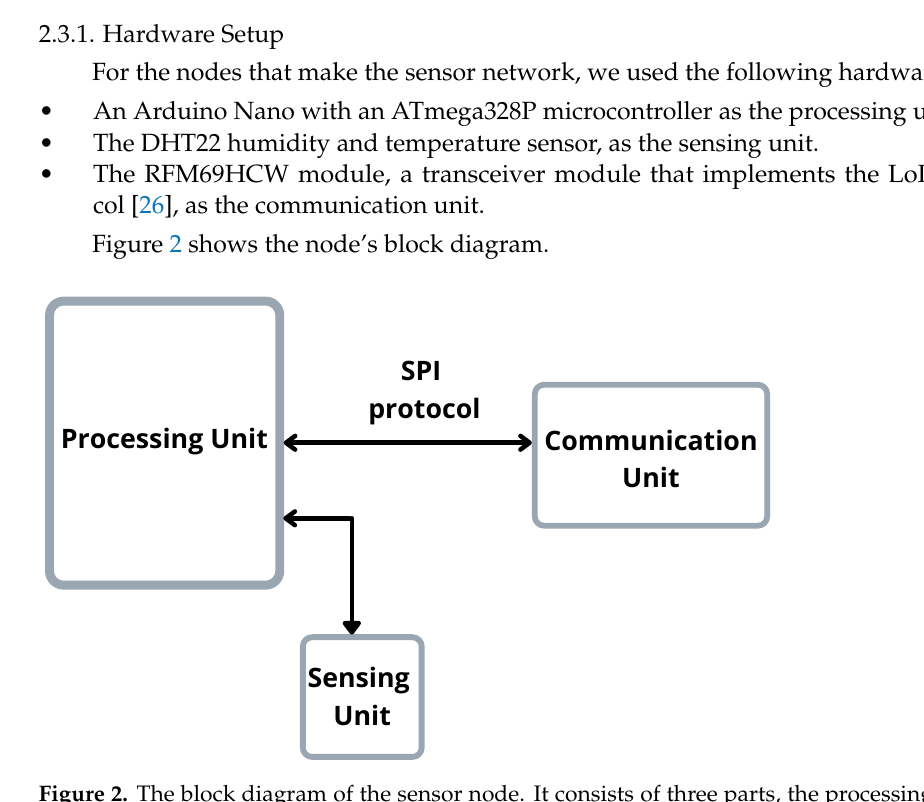
Figure 2. The block diagram of the sensor node. It consists of three parts, the processing unit, for which we used an Arduino Uno; the communication unit, an RFM69HCW; and a sensing unit, the DHT22 sensor.